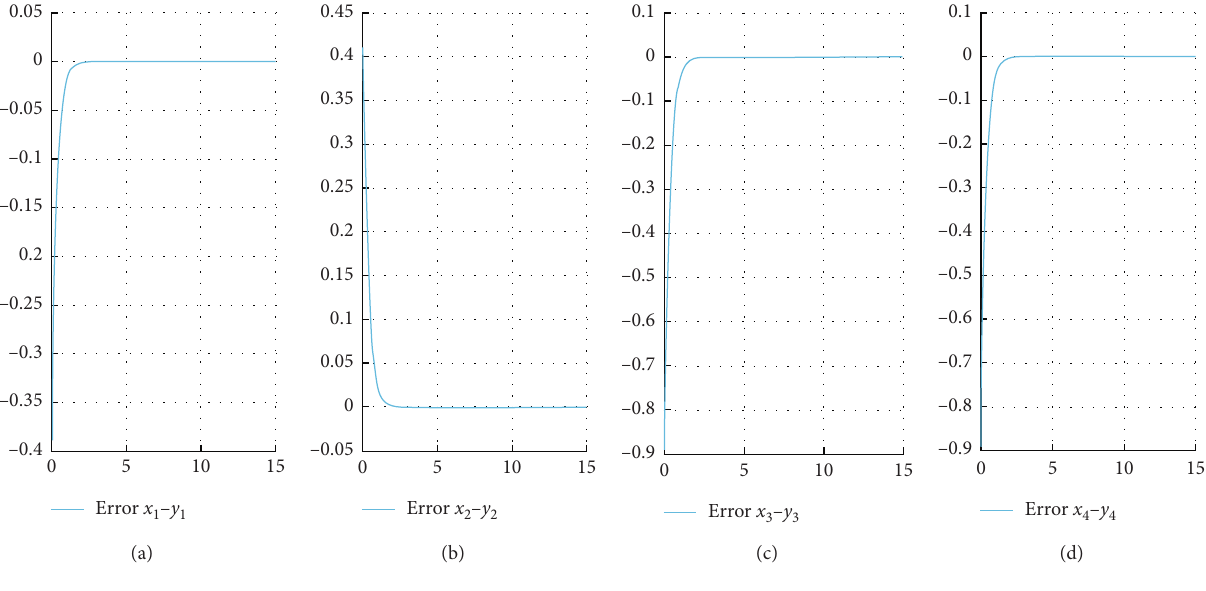
Figure 8: Synchronization